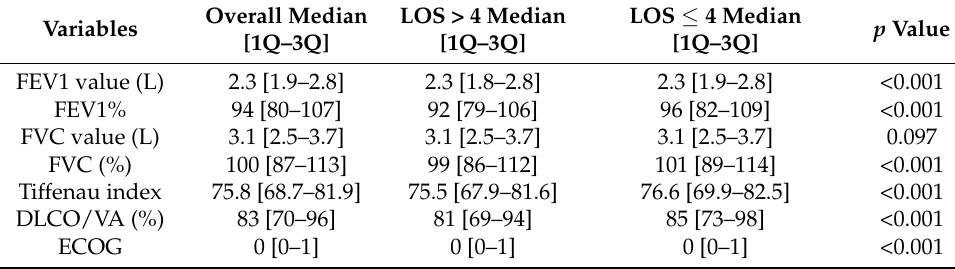
Table 3. Preoperative pulmonary function